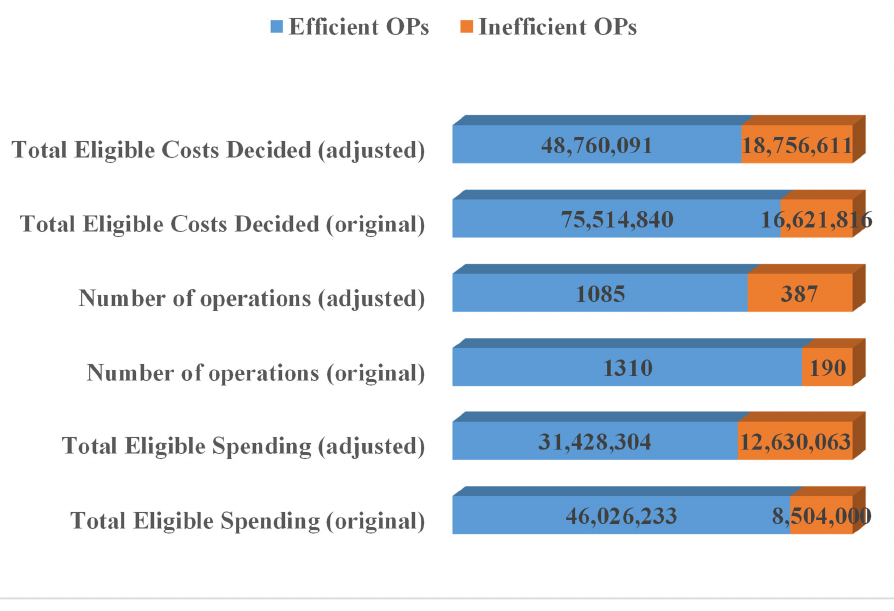
Figure 9. Average input and output values attained for the efficient and inefficient OPs with and without adjusted factors. J. Open Innov. Technol. Mark. Complex. 2022 , 8 , x FOR PEER REVIEW Figure 10 suggests that if the effect of environmental factors is removed from the analysis, the number of operations supported is no longer the only factor that requires more attention from MAs. There are now 17 OPs that require a reduction in “eligible costs decided”, i.e., a reduction in the amount of funding allotted to ICT in SMEs. In addition, the enhancement of “eligible spending” is also an important barrier to efficiency for the same number of OPs.